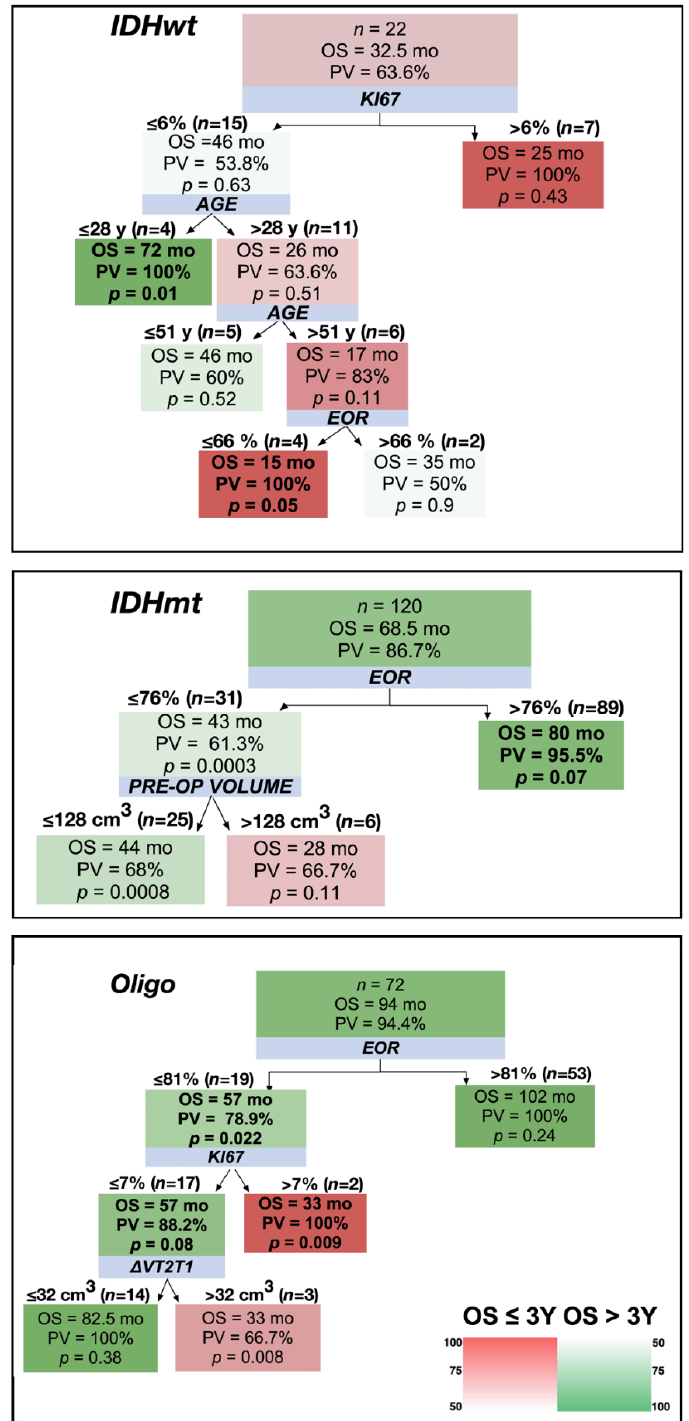
Figure 3. Decision trees applied to the three LGG molecular classes considering 3-year OS as a cut-o ff . The shading color of the cells indicates the predictive value (PV) of an OS superior (green) or inferior (red) to 3 years (see color heat map). Blue boxes show the variables stratifying the population. On top of the detected subgroups are shown the cut-o ff values and the number of patients satisfying them. Within the branches, boxes show the median OS of the patient subgroup, the PV, and the results of the Mann–Whitney test ( p -value) comparing the subgroup OS with that of the general population (top box). In bold are indicated the subgroups characterized by a PV > 75% and a p < 0.05.